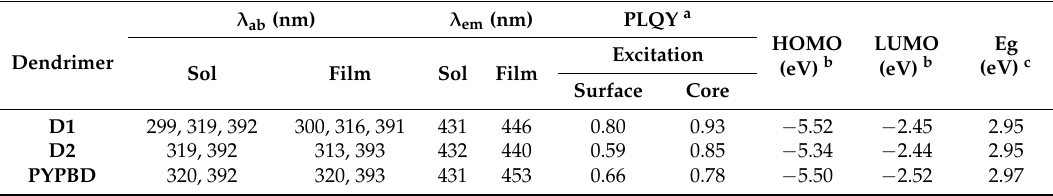
Table 1. Photophysical and electrochemical properties of dendrimers.